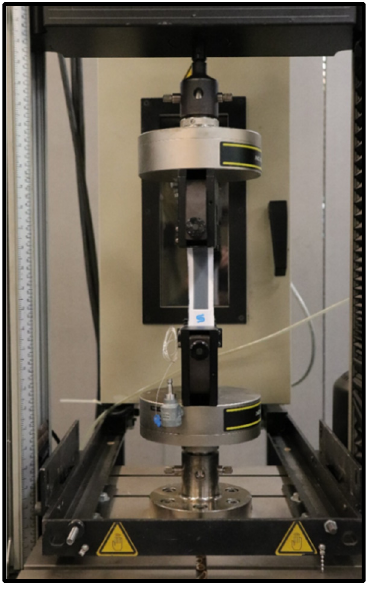
Figure 22. Instron TM fatigue testing setup.